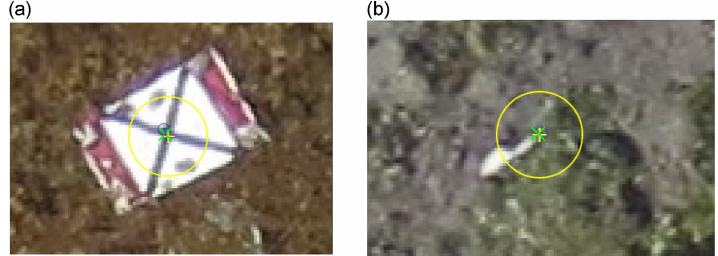
Figure 3. Examples of ground control points that included (a) tarps (2.2m × 1.3m) and (b) identifiable rocks at the same magnification as the